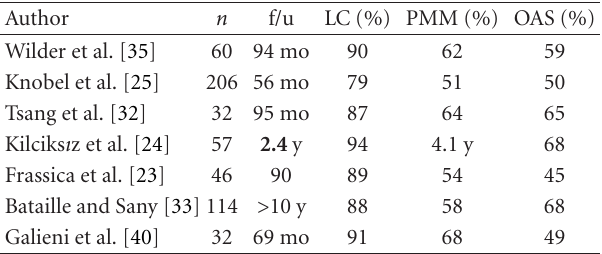
Table 2: Solitary Extramedullary Plasmacytoma: Representative Treatment